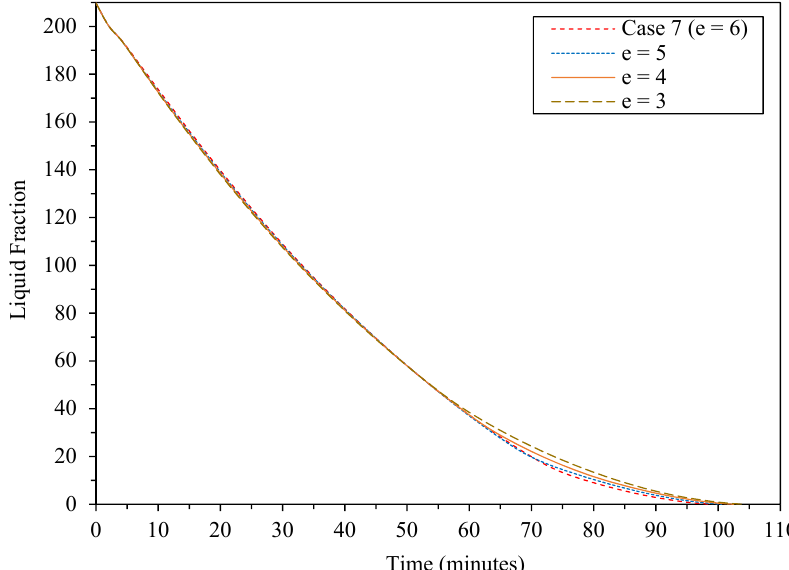
Figure 10. Transient liquid fraction for different eccentricities of the sector tube.